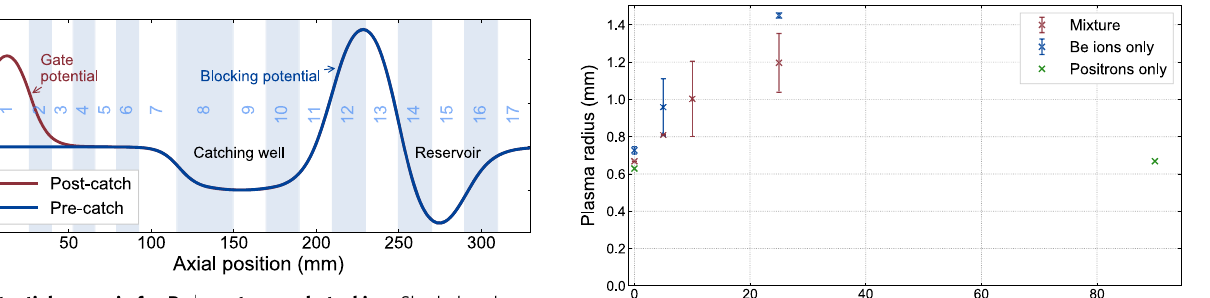
Fig. 6 Potentials on-axis for Be + capture and stacking. Shaded and numbered regions represent electrode positions. Ions enter from the left into the blue potential. Subsequently, the gate electrode (E1) is raised to 40 V (red potential) to capture them. Ions are then moved to the reservoir where they are combined with previous loads and laser-cooled until the desired number of stacks have been accumulated.